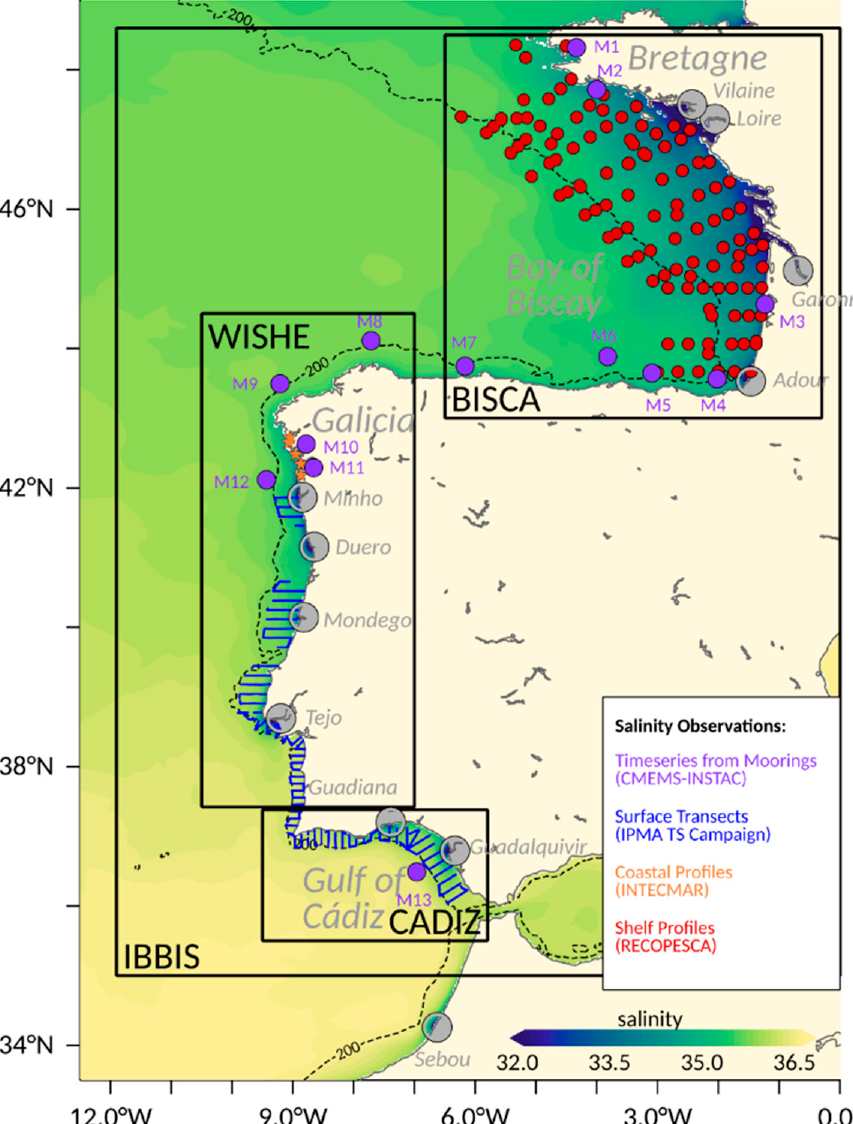
Figure 2. Study Domain. Location of the in-situ measurements used in this study: fixed moorings (purple), surface transects with thermo-salinometer (blue), coastal profiles with CTD (Conductivity, Temperature, and Depth) instrumentation (orange) and profiles with XBT (eXpendable BathyThermograph) instrumentation (red). Black rectangles show subregions in which the study is focused (IBBIS, CADIZ, WISHE, BISCA). The names of the main rivers included in the IBI model set-up and the geographical features mentioned in the paper are denoted in grey. The shaded field shows the IBI averaged surface salinity over the year 2018, from the reference simulation; the 200 m isobath, delimiting the shelf, is depicted in dashed line.